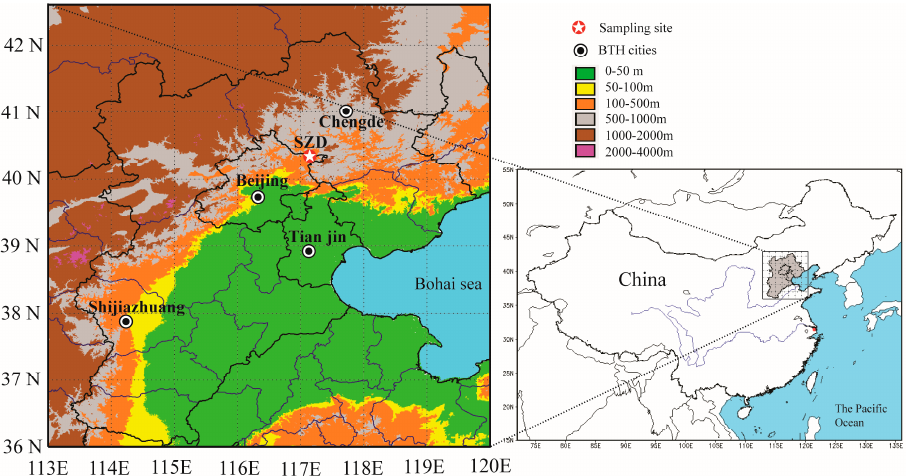
Figure 1. The sampling location at Shangdianzi (SDZ) regional station in Beijing–Tianjin–Hebei (BTH).